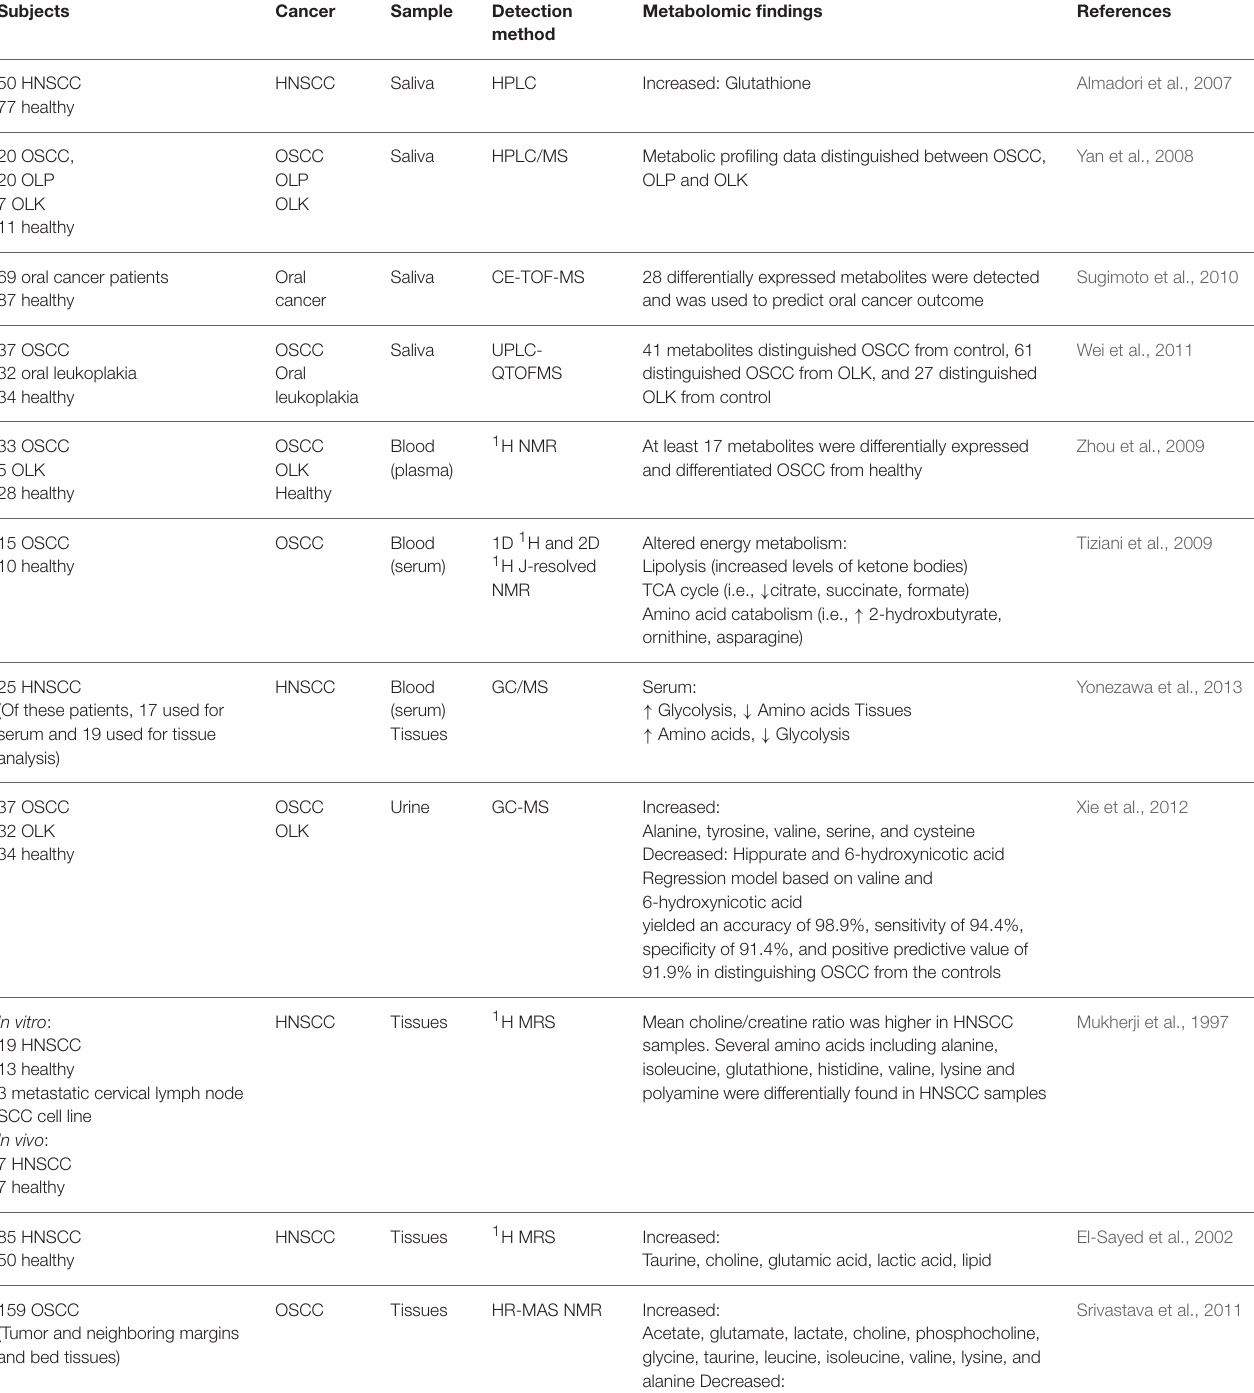
TABLE 1 | Summary of metabolomic-based studies on head and neck